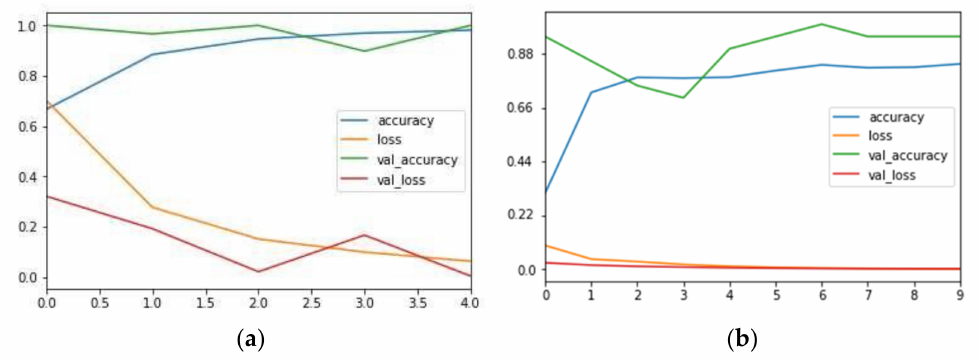
Figure 10. ( a ) Training result of model one. ( b ) Training result of model two. Transverse axis is the train steps, vertical axis is the accuracy (no more than